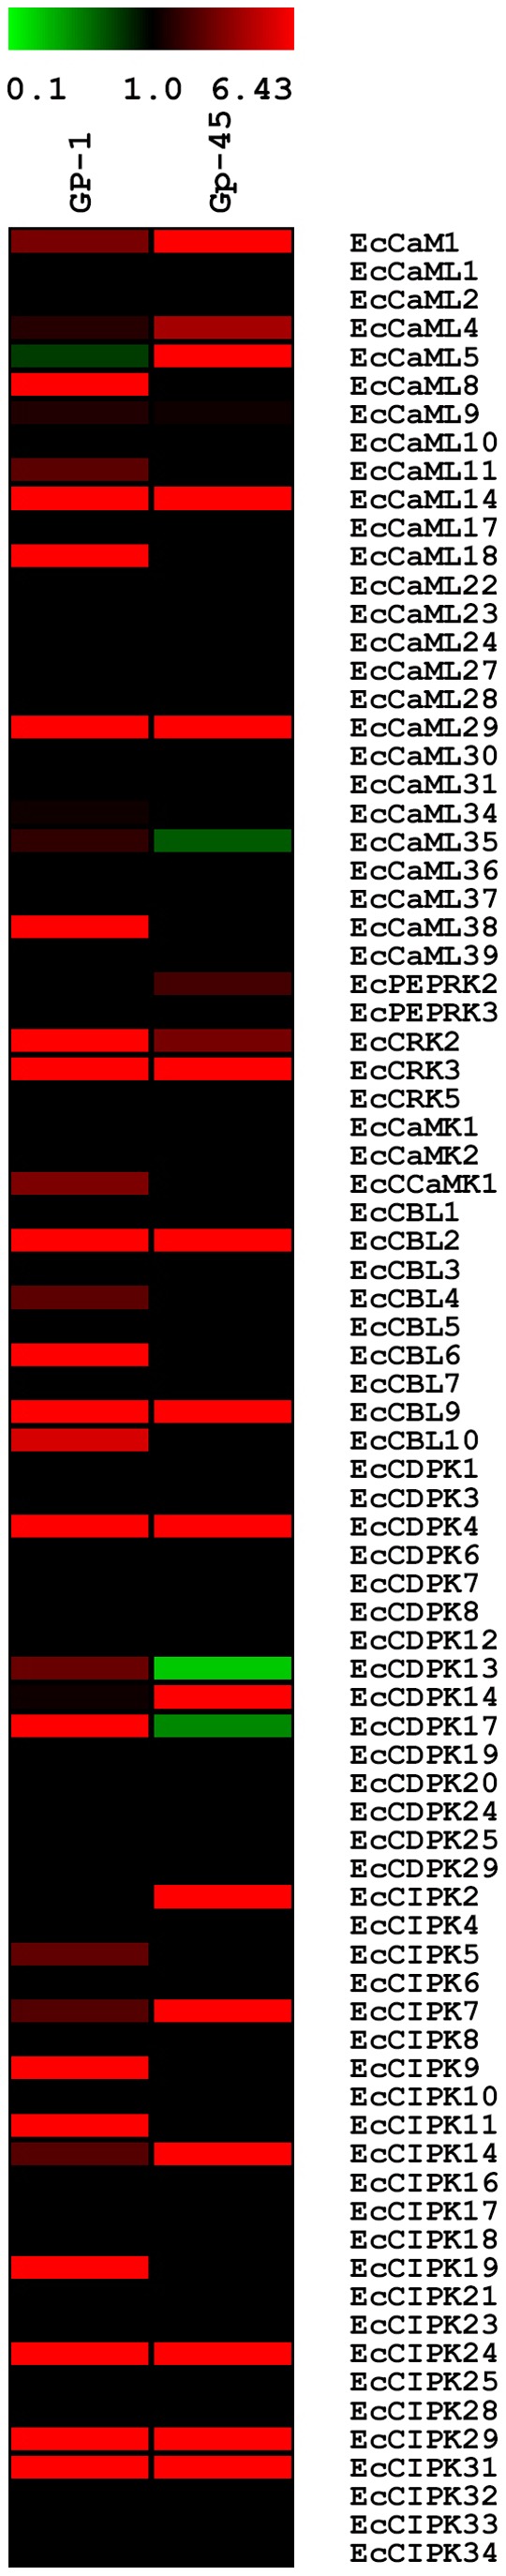
Expression of 82 Calcium sensor genes in pooled spikes of GP-1 (Low calcium) and GP-45 (High calcium) genotype.The number indicated on each cell represents the log2 calculated FPKM values. FPKM values smaller than 1 were not calculated due to negative logarithm and they were stated as in the original data.